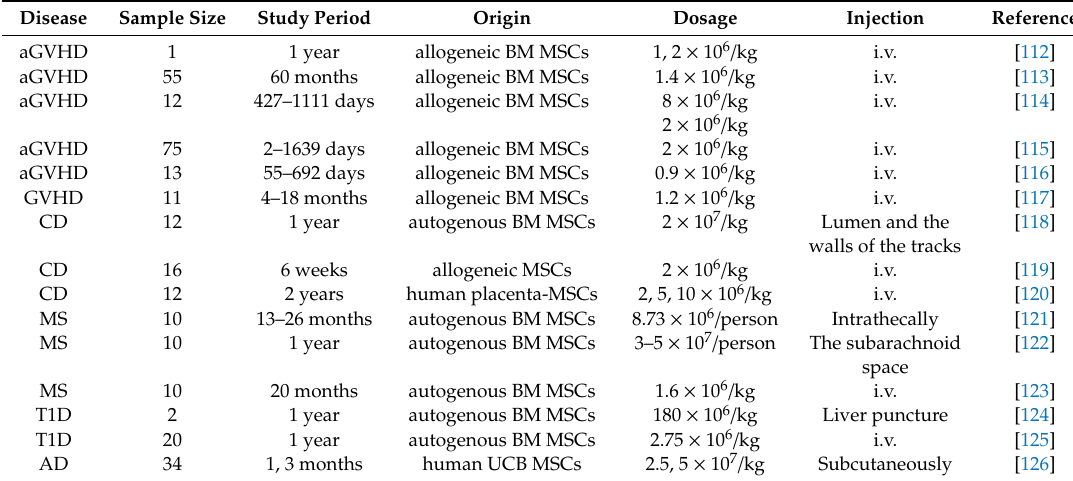
Table 1. Summary of the clinical application of